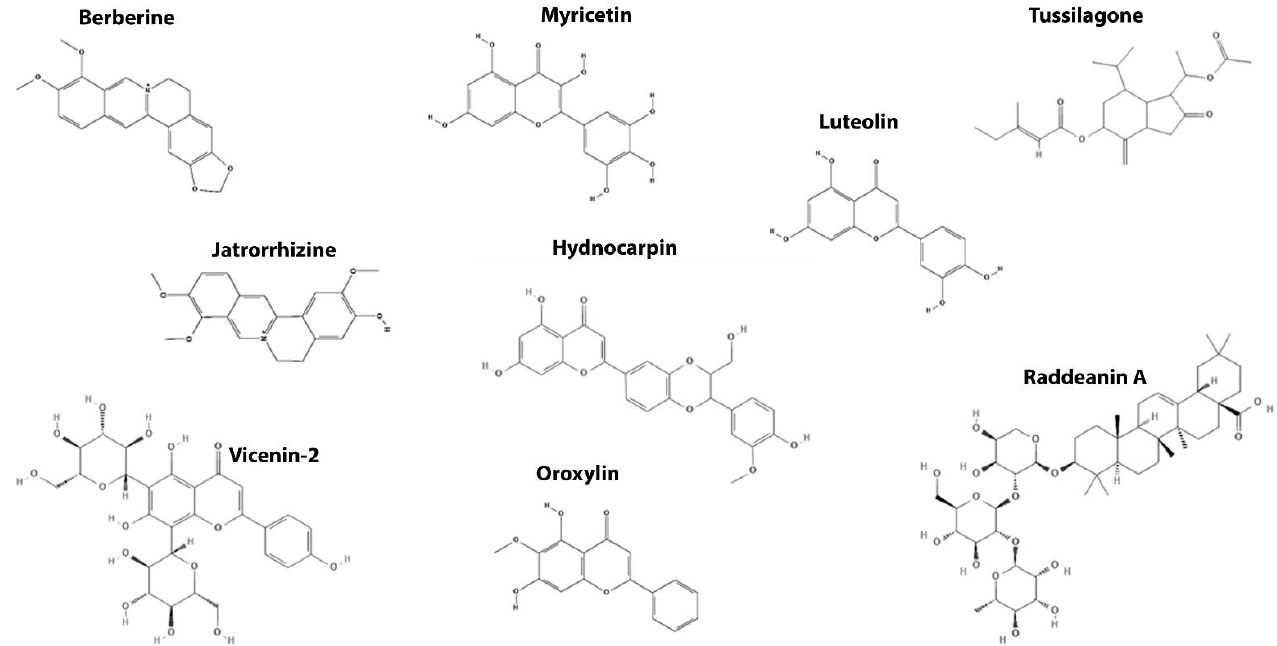
Figure 4. Chemical structures from the naturally occurring small molecules that target the destruc- tion complex components in the Wnt/β-catenin signaling